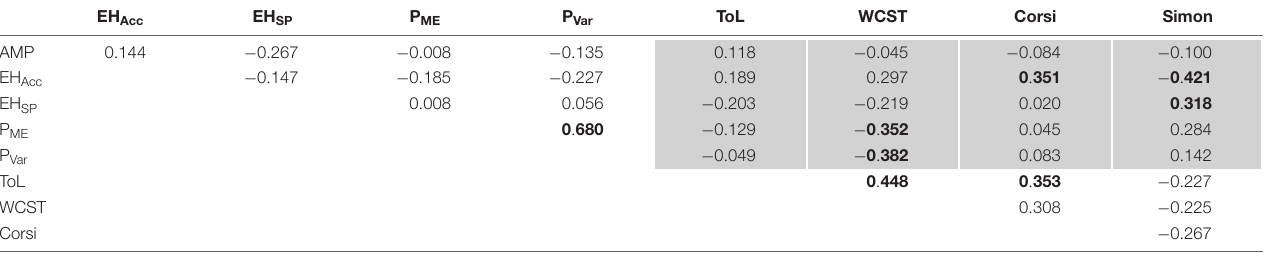
TABLE 2 | Partial correlations controlled for age between sensorimotor skill components and measures of executive functioning in children. EH Acc EH SP